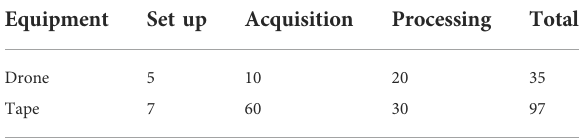
TABLE 6 Comparative analysis of operation time (Minutes).